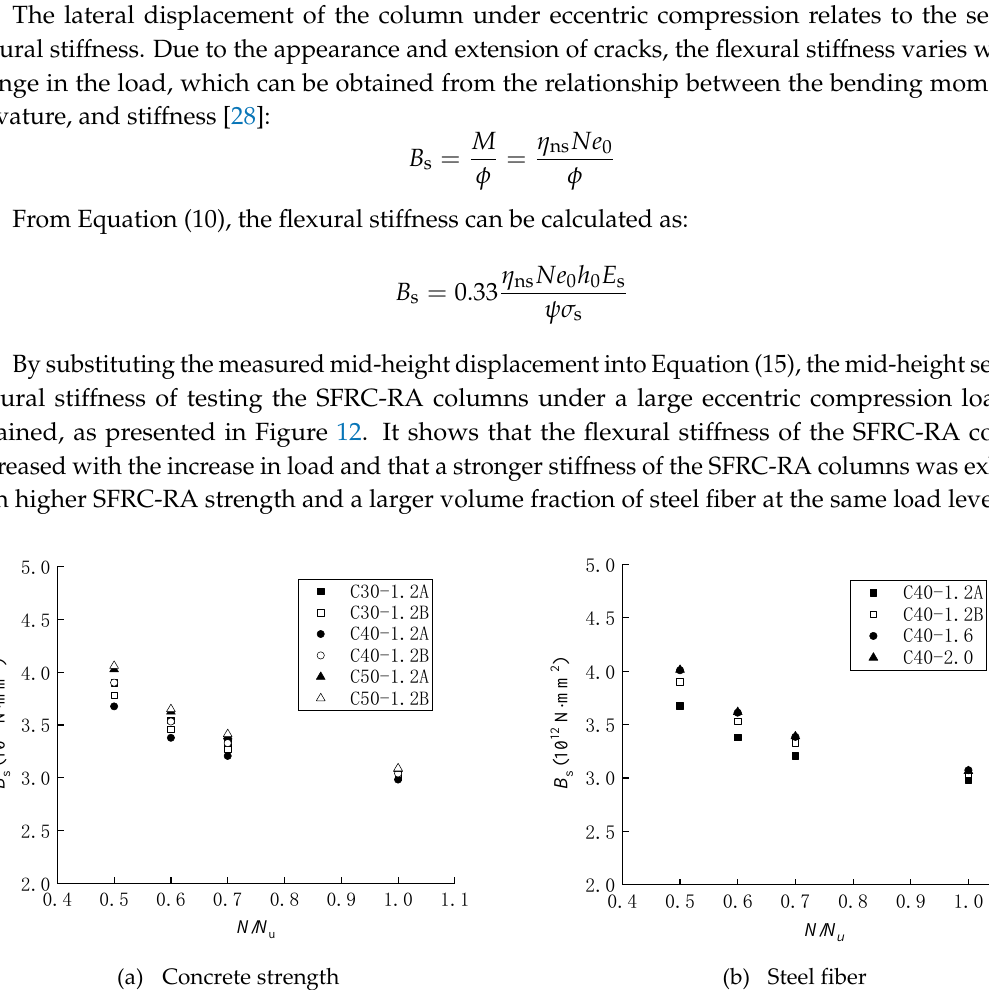
Figure 11. The displacement curves along the height of the columns: ( a ) C30 - 1.2A; ( b ) C30 - 1.2B; ( c ) C40 - 1.2A; ( d ) C40 - 1.2B; ( e ) C50 - 1.2A; ( f ) C50 - 1.2B; ( g ) C40 - 1.6; ( h ) C40 - 2.0.